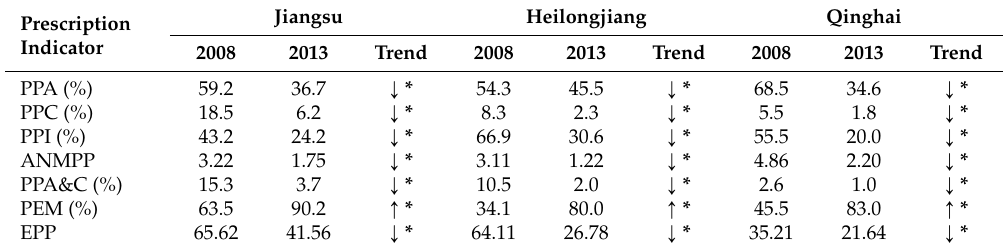
Table 4. Comparison of changing prescribing patterns across the three provinces (2008 and